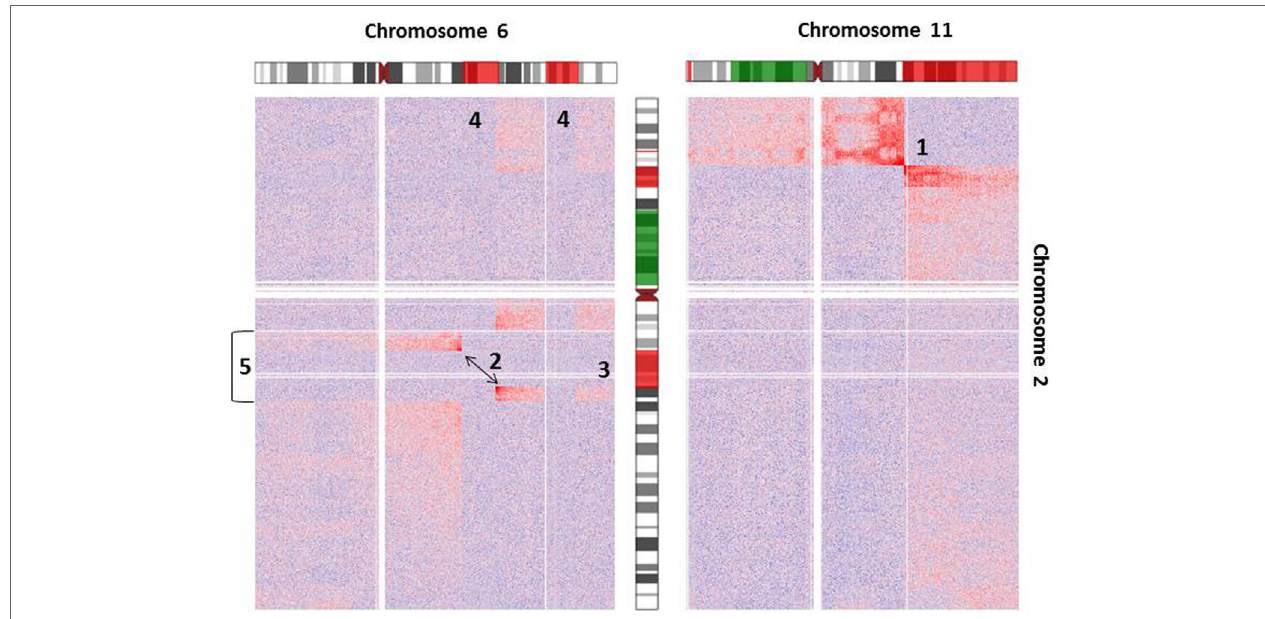
FigUre 3 | Heatmap of normalized interchromosomal interaction frequencies between chromosomes 2 and 6 and chromosomes 2 and 11. Two heatmaps are shown, which demonstrate the presence of a translocation t(2;6) (left) and t(2;11) (right), respectively. Both derivative chromosomes lead to higher than expected interchromosomal interaction frequencies, which are indicated by the red color gradient. Alterations of DNA copy number state as detected by array comparative genomic hybridization is indicated by coloring of the chromosome ideograms (red = deletion, green = gain). While the breakpoint of reciprocal translocation t(2;11) is easily identifiable [1], the identification of t(2;6) [2] is complicated by additional deletions of chromosome 2 [3] and chromosome 6 [4] and an inversion of chromosome 2 [5]. Orientation of chromosomal rearrangements can be inferred from the color gradient [interaction intensities (i.e., red color) decrease with distance from chromosomal breakpoints].